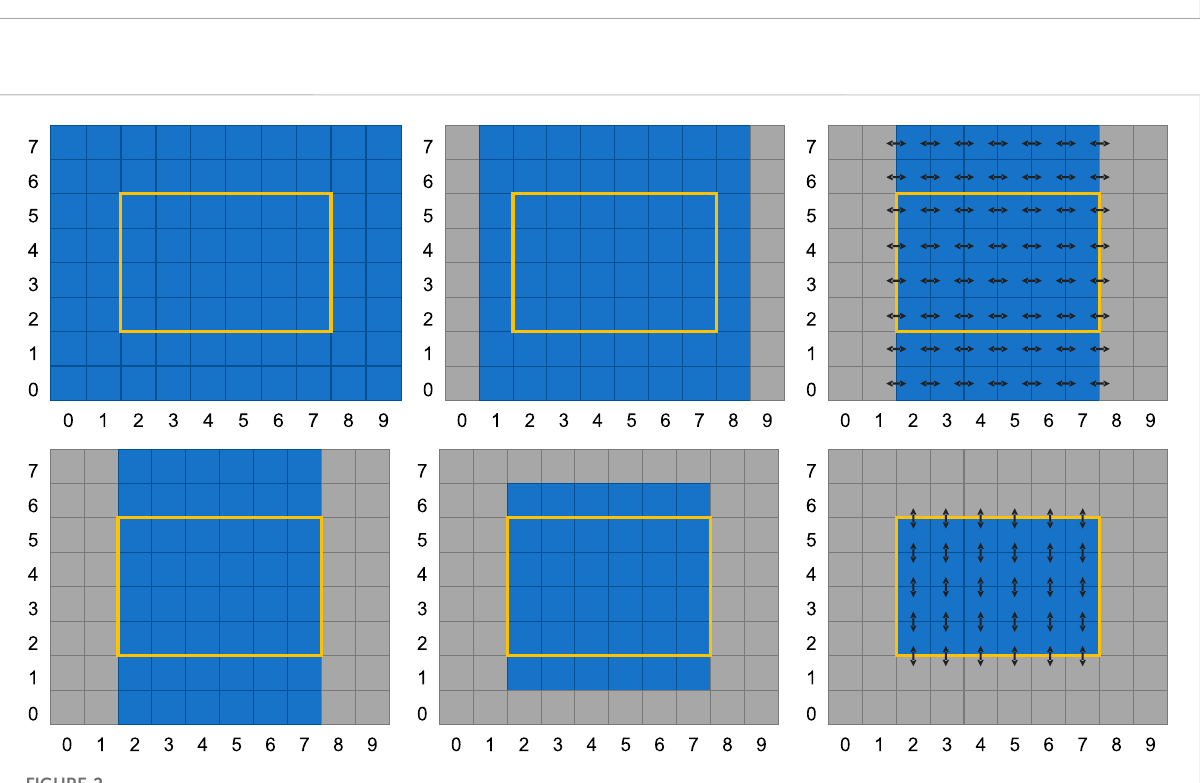
FIGURE 1 Program fl ow on a single GPU. All the boxes within the dotted square represent stages within the CUDA kernel. After completing all the CUDA kernelstages,thesimulationisadvancedonestepintime.Thedashedboxesareoptional,andifthemaxtime-stepsizeifnotcomputed,a fi xedtime- step size must be given.